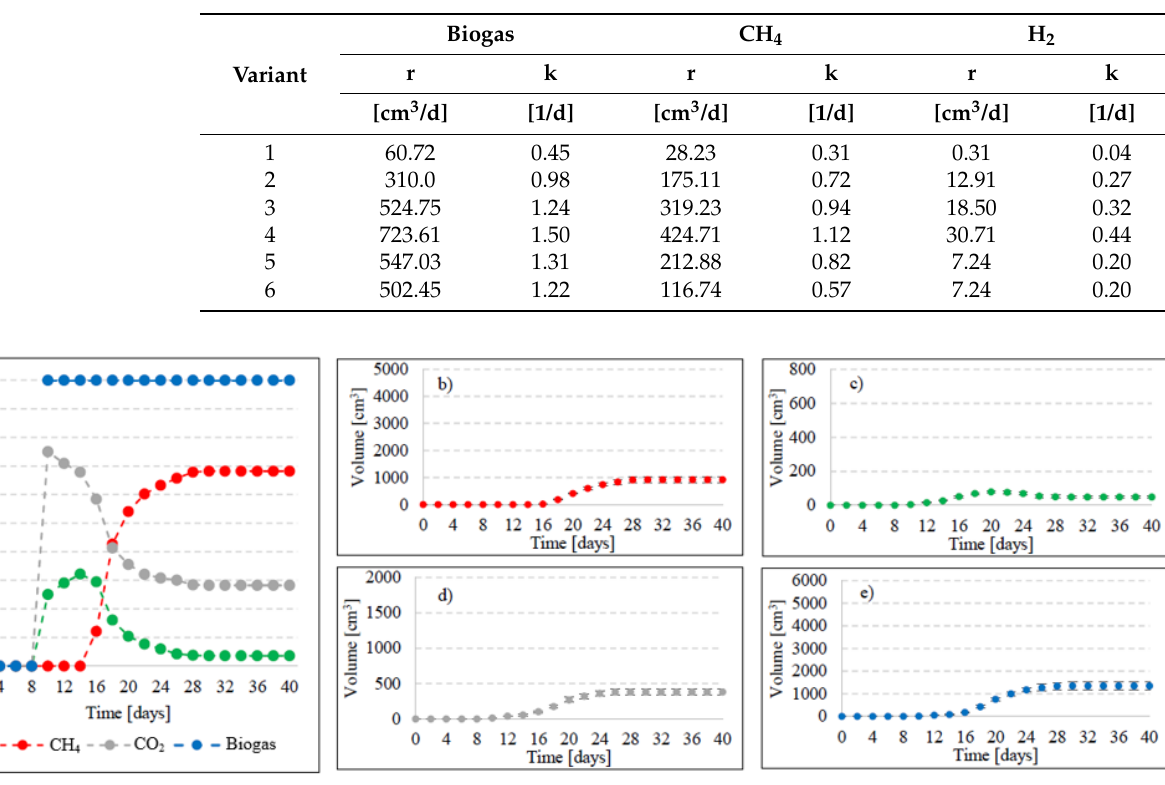
Figure 2. Production of biogas, CH 4 , and H 2 in particular technological variants. Table 1. Rates (r) of production processes of biogas, CH 4 , and H 2 , and reaction rate constants (k).